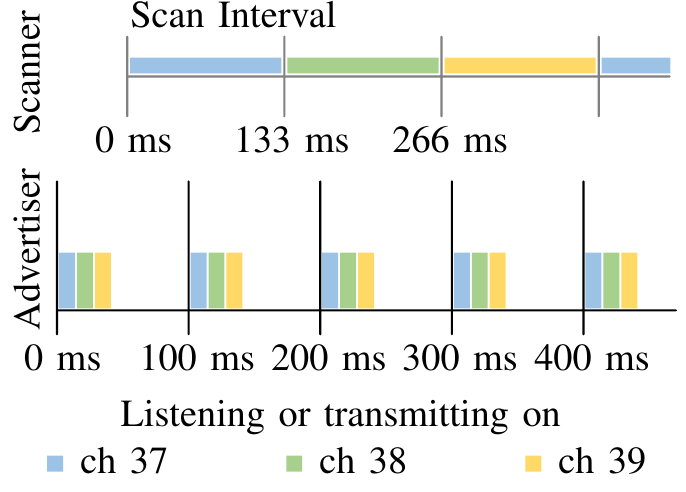
Fig. 1. Block diagram of the BLE-based localization system using SIMO approach (based on [12]).